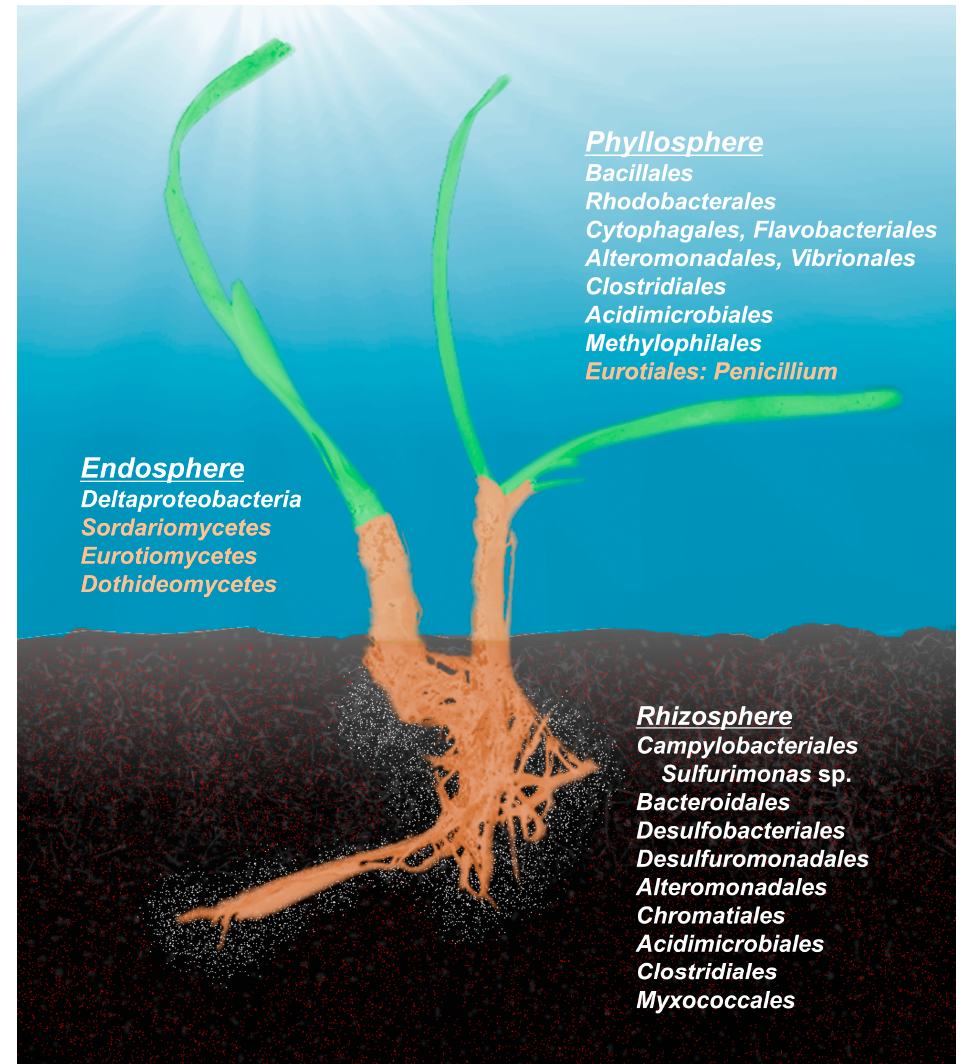
Figure 2. The most abundant bacterial ( white fonts ) and fungal groups ( orange fonts ) identified within different compartments of the seagrass